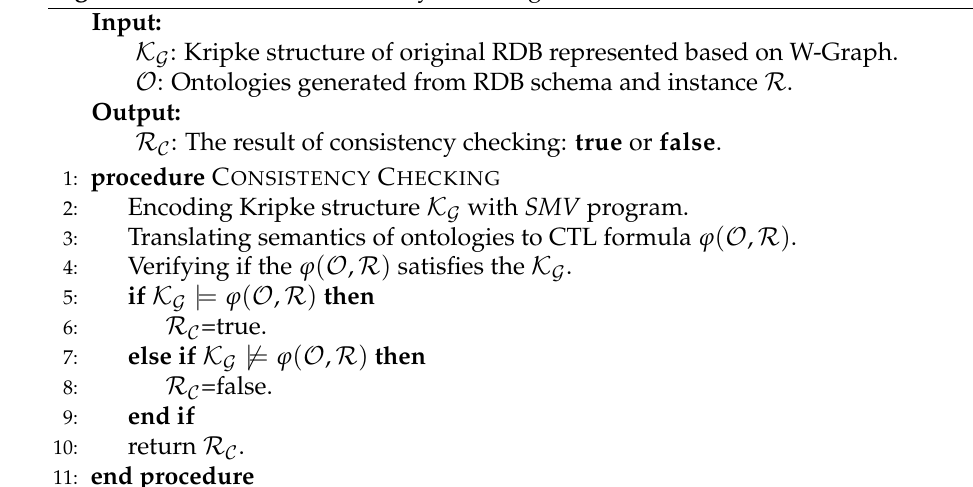
Algorithm 1 Semantic Consistency Checking based on nuXmv Model